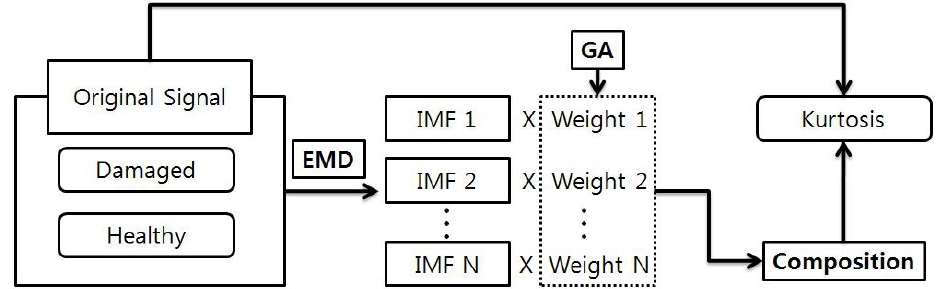
Figure 12. A schematic block diagram for the process of sensitivity enhancement of a bearing defect through